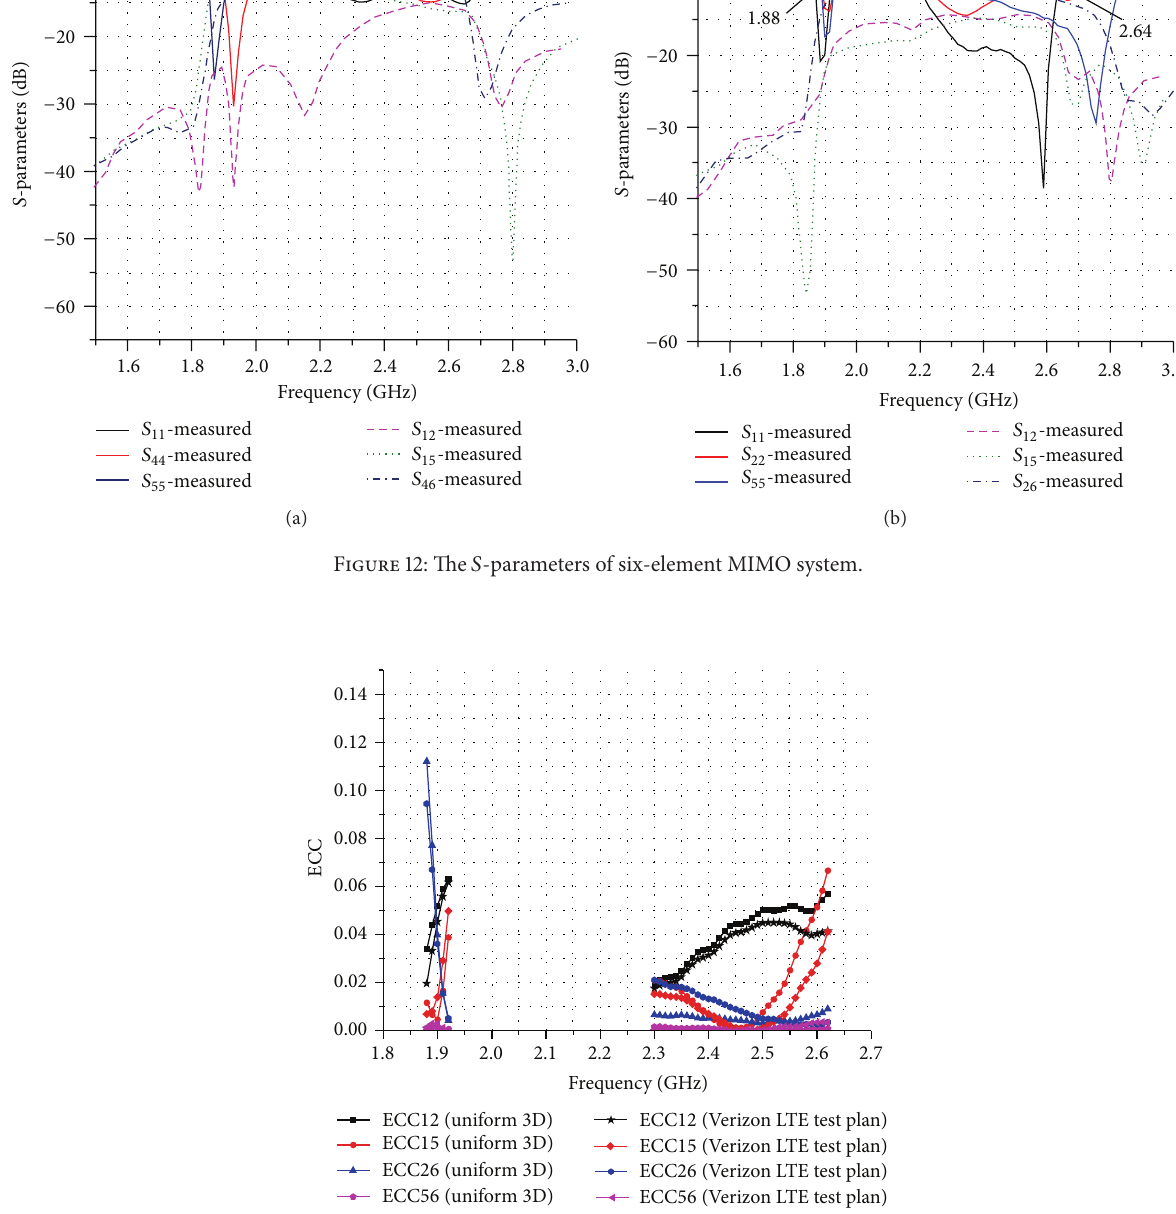
Figure 13: The ECC of six-element MIMO